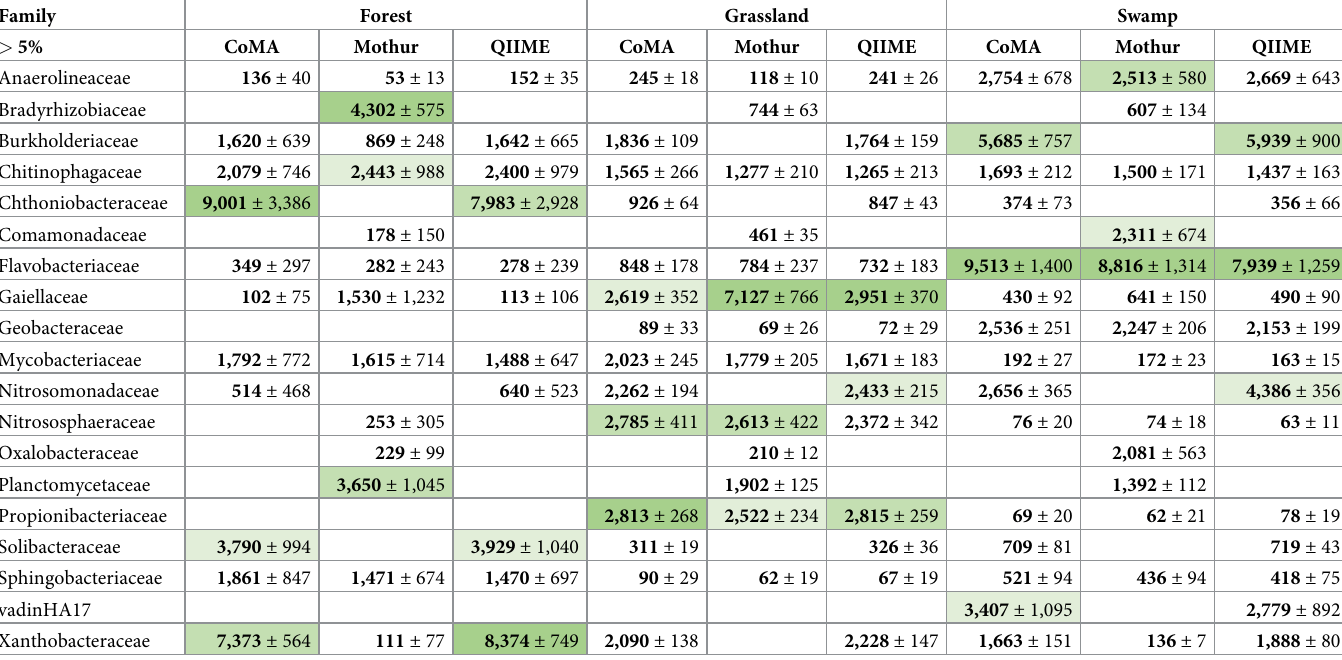
Table 4. Key microbial families found in three different habitats: Forest, grassland and soil. Family